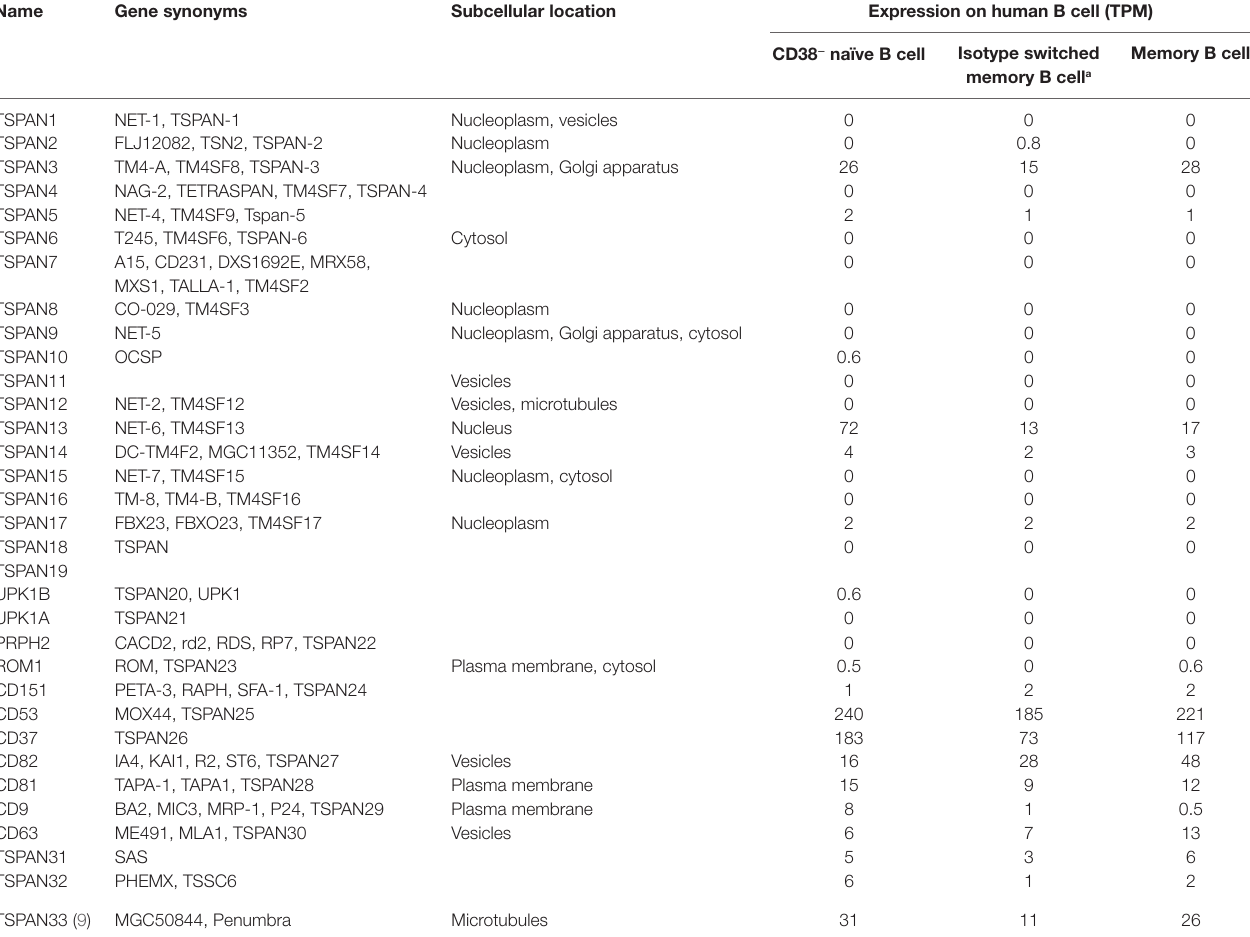
TABLe 2 | Expression of tetraspanins on B